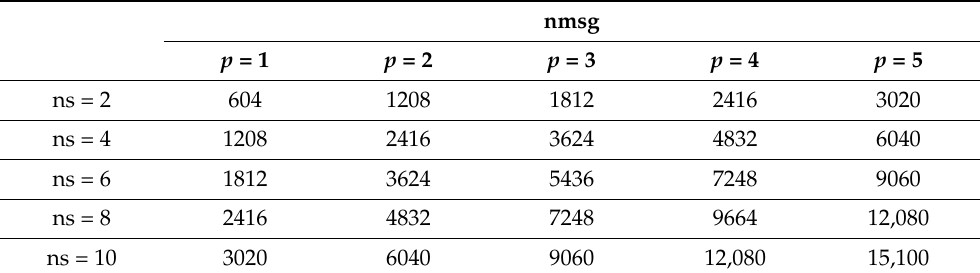
Table 3. Effect of the number of sensors ns and the number of parks p on the number of messages collected during 300 s, with a sampling period sp = 0.94 s.